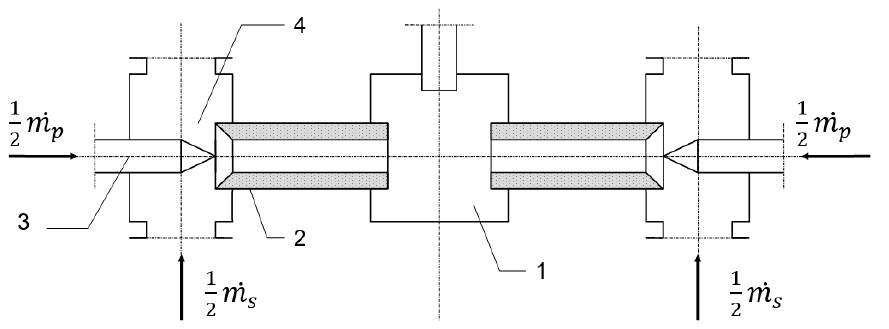
Figure 2. Diagram of the jet mill: (1)—grinding chamber, (2)—acceleration tube, (3)—nozzle and (4)—suction chamber.